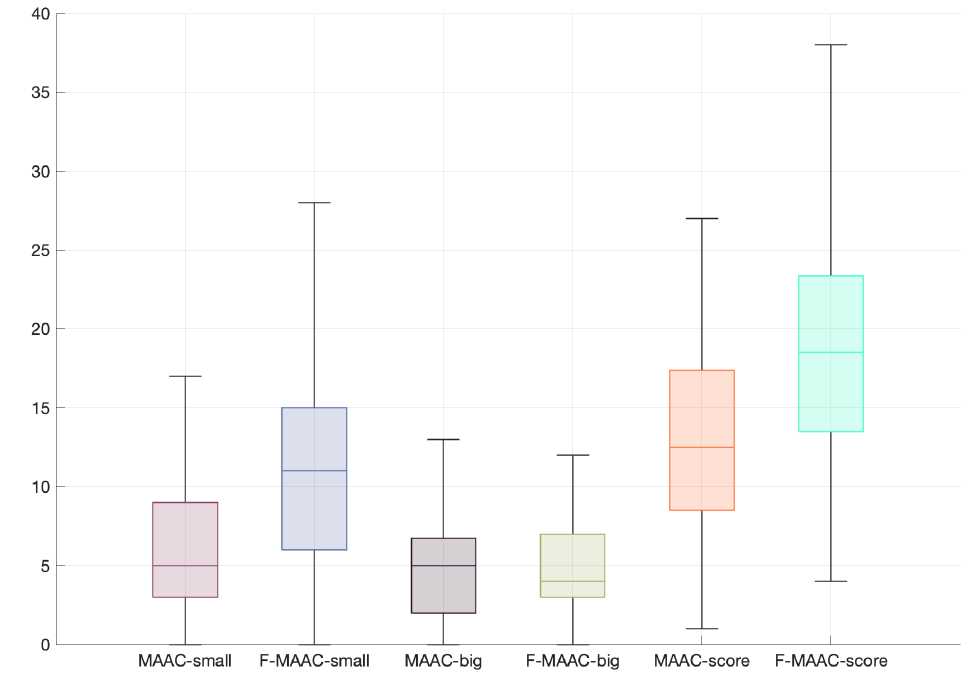
Figure 11. Comparison of delivery